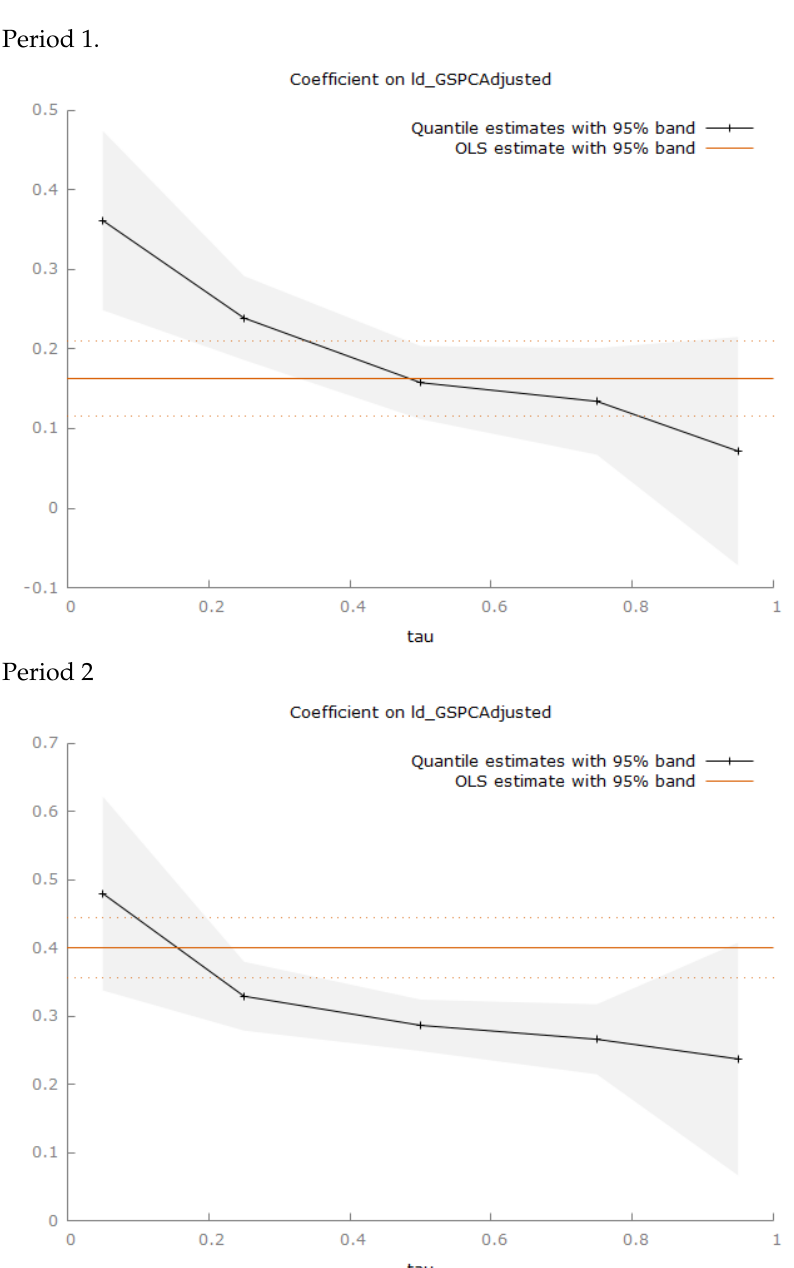
Figure 5. Tau Sequence—Quantile